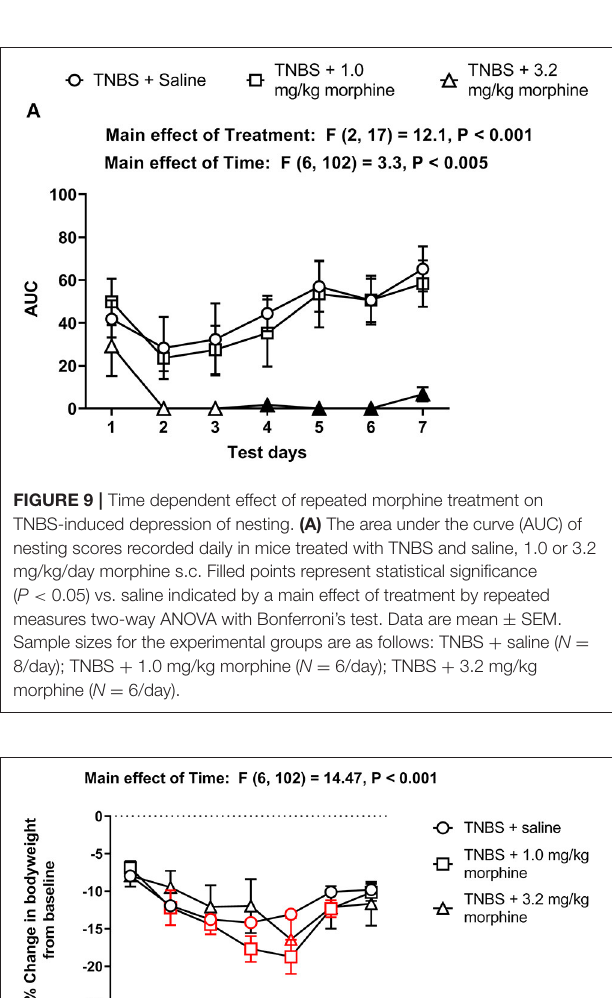
FIGURE 8 | Filled points represent statistical significance ( P < 0.05) vs. saline as indicated by a significant treatment x time interaction in the two-way repeated measures ANOVA with Bonferroni’s test. Data are mean ± SEM. Sample sizes for the experimental groups are as follows: TNBS + saline ( N = 8/day); TNBS + 1.0 mg/kg morphine ( N = 6/day); TNBS + 3.2 mg/kg morphine ( N = 6/day).